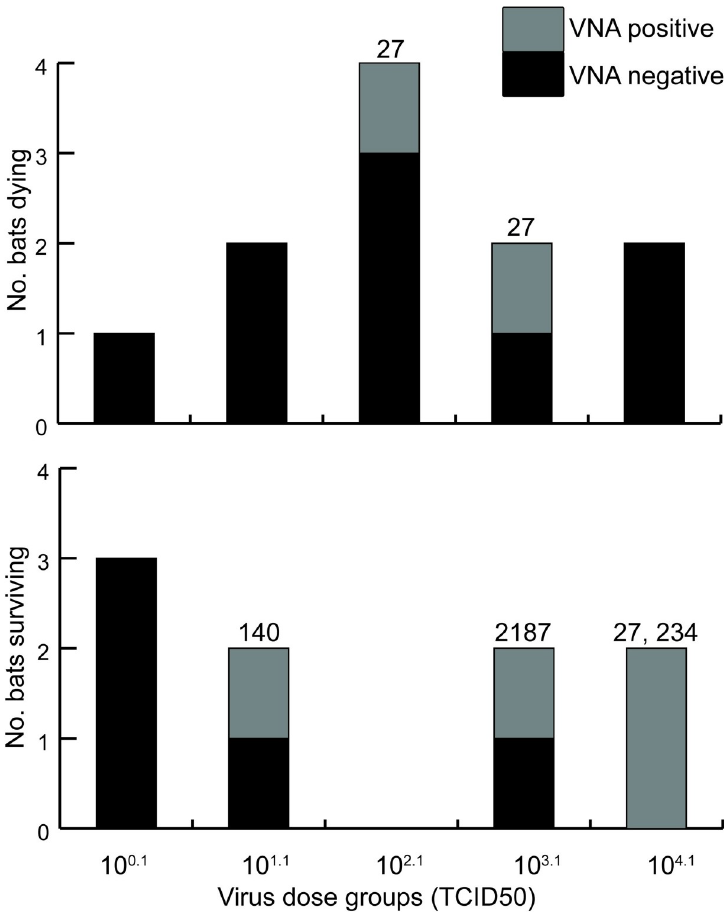
Fig 2. Comparison of virus-neutralizing antibody response between straw-colored fruit bats that died or survived after inoculation with different doses of Lagos bat virus. The numbers on top of the stacked column are reciprocal VNA